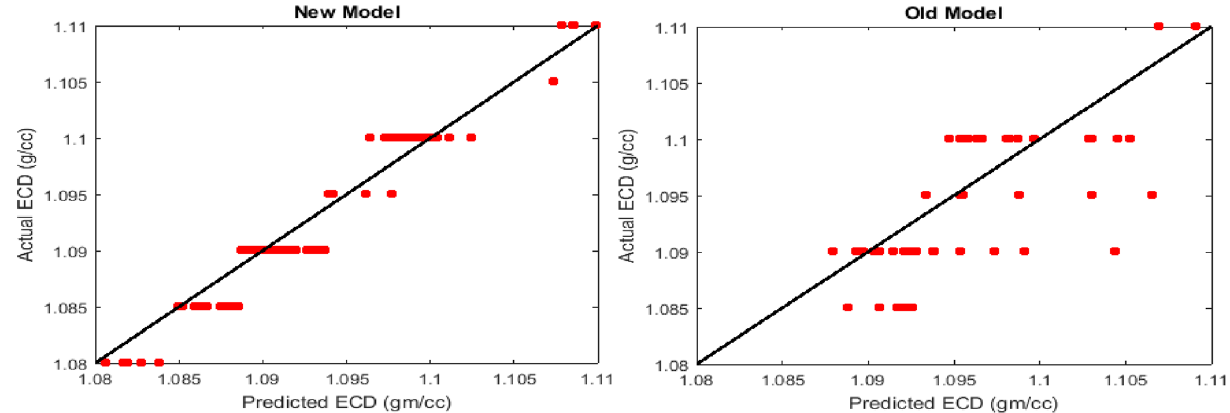
Fig. 35 Predicted versus actual ECD for severe and complete losses